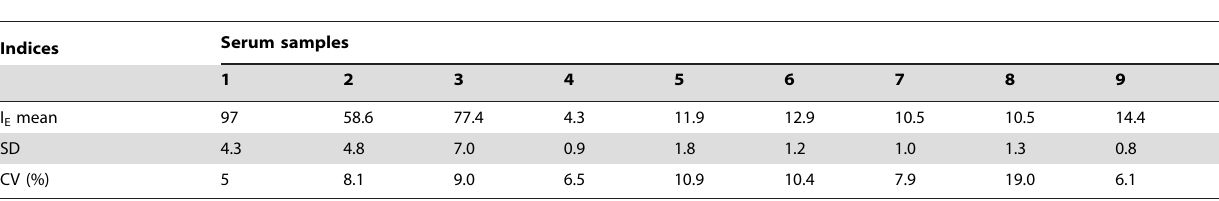
Table 3. ELISA reproducibility.